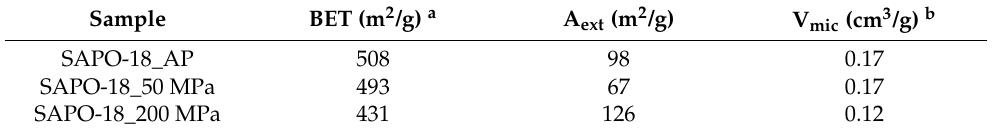
Table 1. Textural properties of calcined SAPO-18 samples obtained under autogenous pressure